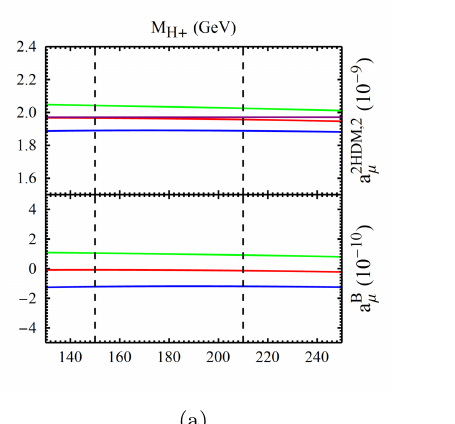
, and a B . Each µ µ and M H vary in (a) and (b) respectively. We set H ±